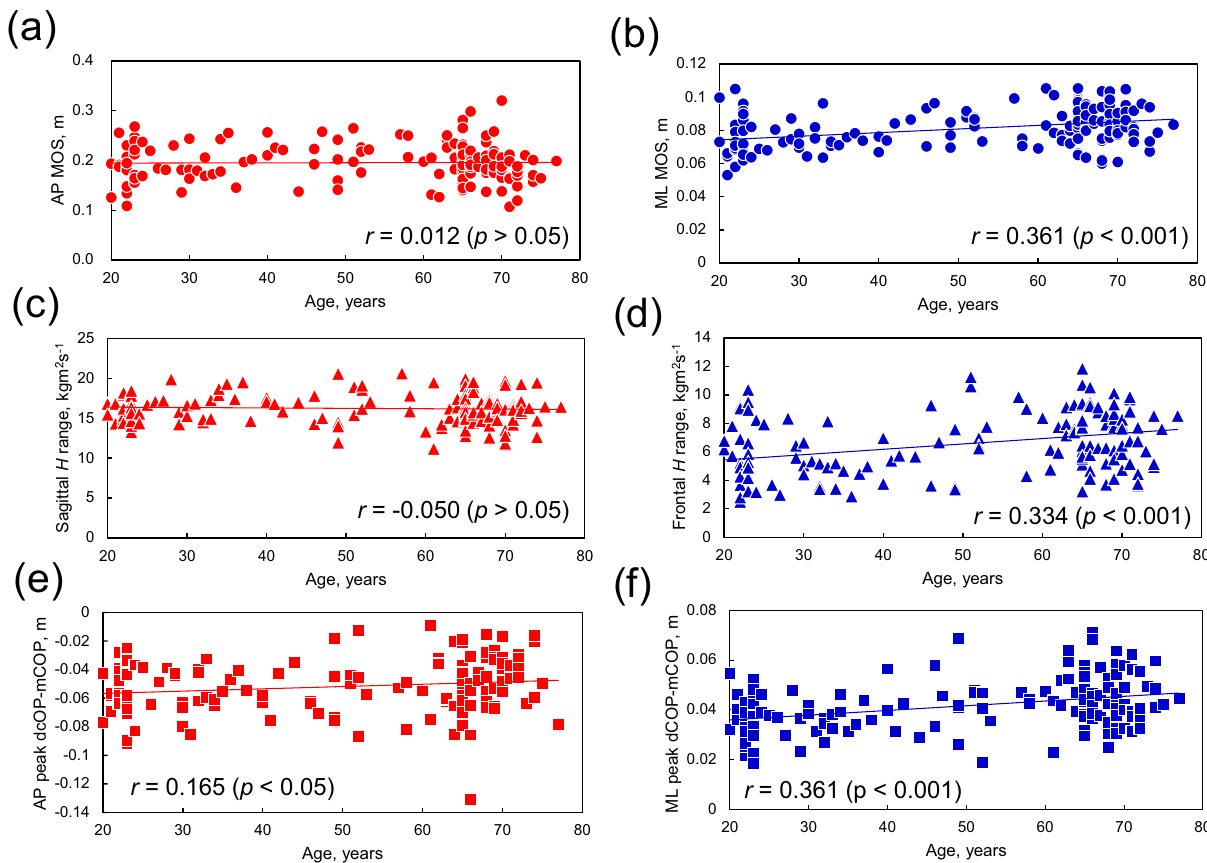
Figure 2. Relation between age and dynamic balance measures: ( a ) anteroposterior (AP) margin of stability (MOS), ( b ) mediolateral (ML) MOS, ( c ) sagittal H range, ( d ) frontal H range, ( e ) AP peak desired center of pressure–measured center of pressure (dCOP–mCOP), and ( f ) ML peak